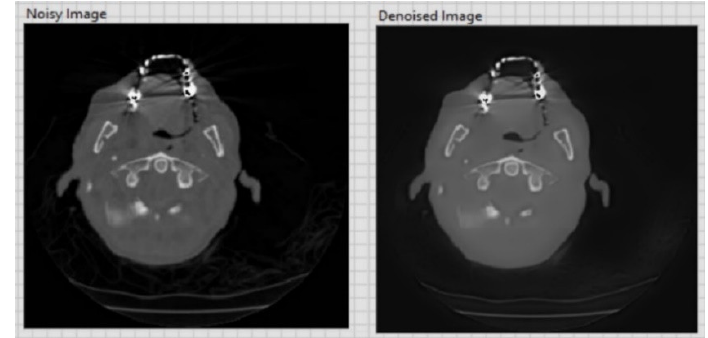
Figure 10. Noise reduction from a CT image, using Haar wavelet [76].